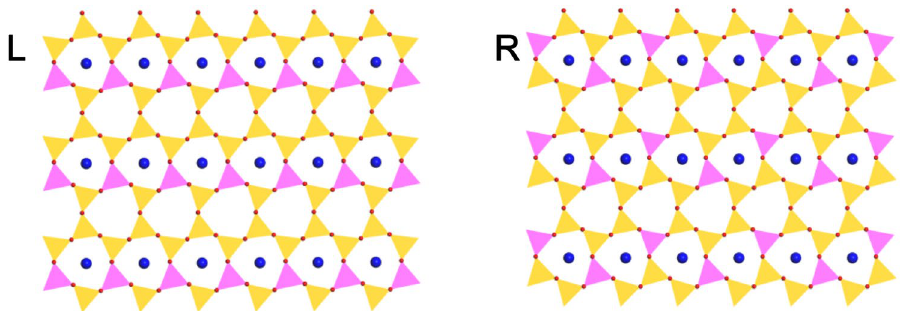
Figure 5. Expanded unit cell of one-layer mica cleaved from bulk mica ( L ) and that with applied shift of tetrahedral Al 3+ atom ( R ). Atoms are shown as colored balls: H (grey), O (red), K (blue), Si (yellow) and Al (pink). The coordination polyhedra around the Si atoms (yellow polyhedra) and Al atoms (pink polyhedra) are shown as well.